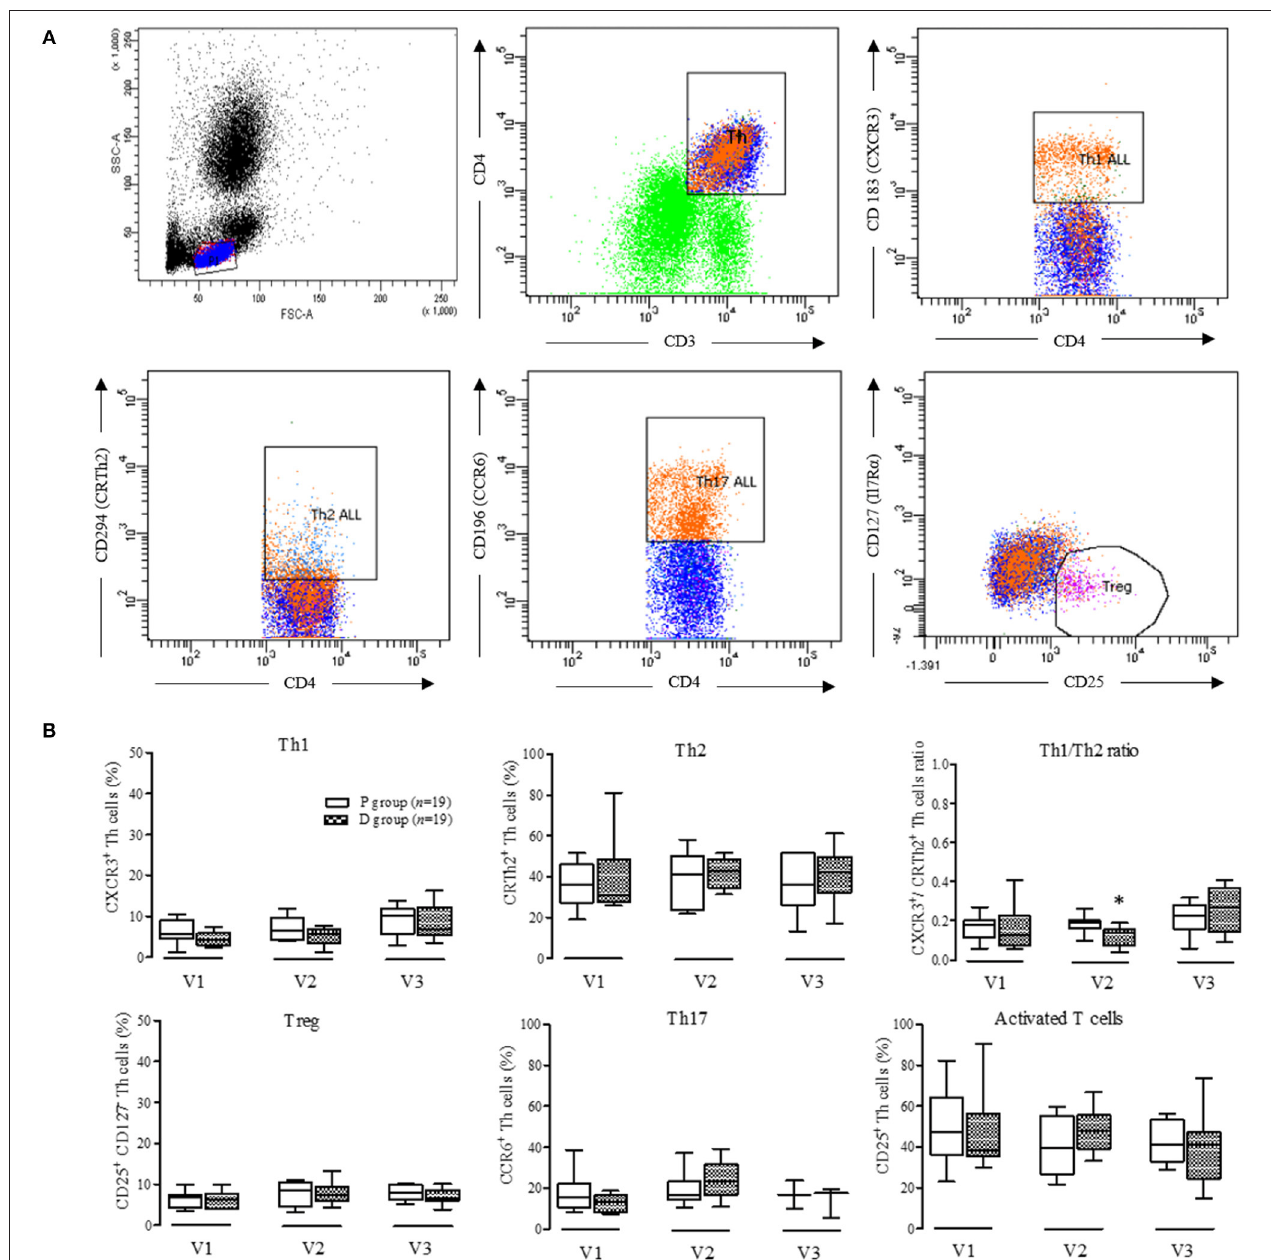
FIGURE 7 | Phenotyping of peripheral blood CD3 + CD4 + T cells. (A) Gating strategy of a representative sample used to identify T helper cells (Th. CD3 + CD4 + ), Th1 cells (CD4 + , CD 183 + ), Th2 cells (CD4 + ,CD294 + ), Th17 cells (CD4 + , CD196 + ), and Treg cells (CD25 + , CD127 − ); (B) Proportion from the different T helper and Treg cells in D group compared to controls. V1, inclusion; V2, end of supplementation and vaccination; V3, 28 days post-vaccination; Data are expressed as mean ± SD. No statistical difference was observed by two-way ANOVA ( p < 0.05); *Determined using Mann-Whitney U -test between P and D groups ( p < 0.05).